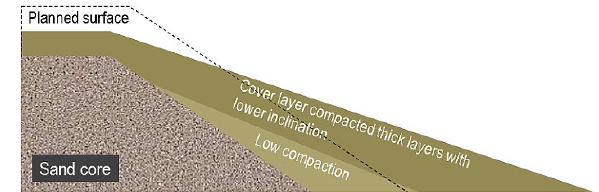
Fig. 6. Steep sand core with installed cover layer in lower inclination and lower compaction at the dike toe